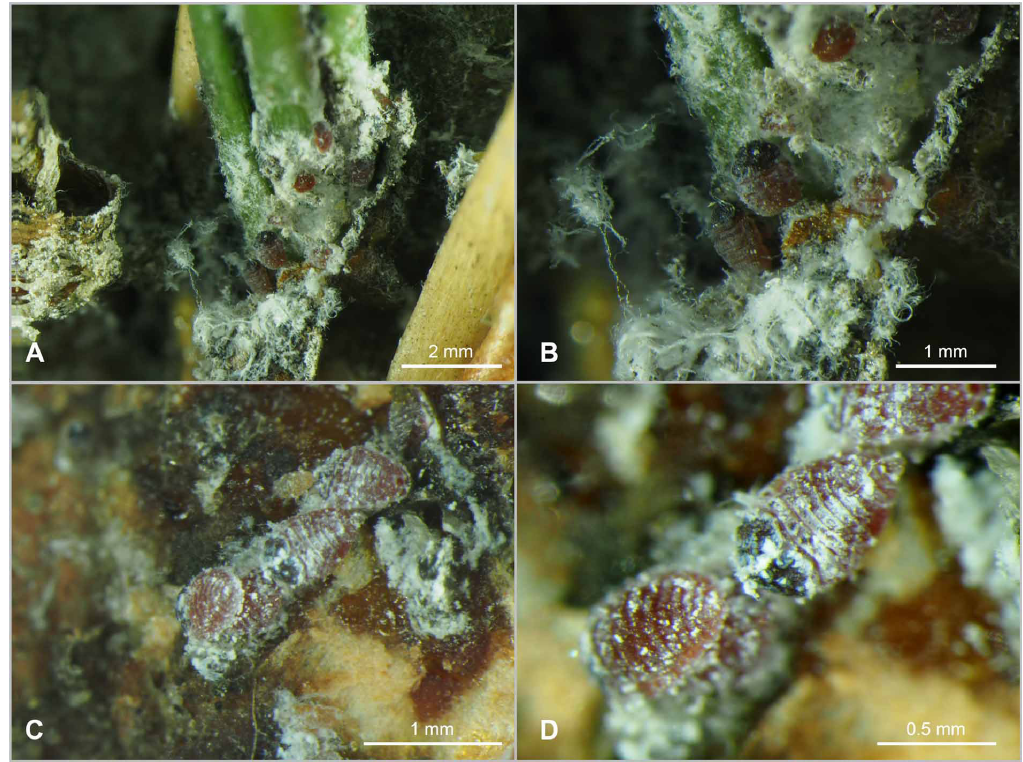
Fig. 79. Pineus (Pineus) cembrae (Cholodkovsky, 1888). Overwintering apterae on twig of Pinus cembra . Bud scales and wax wool